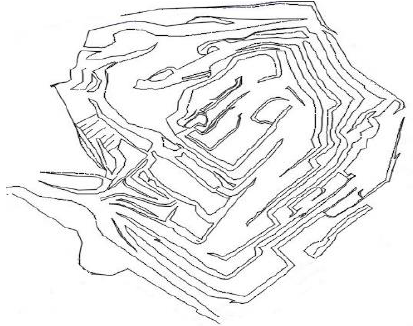
Figure 9. The whole quarry measured by GPS with 615 points for more than 5 hours